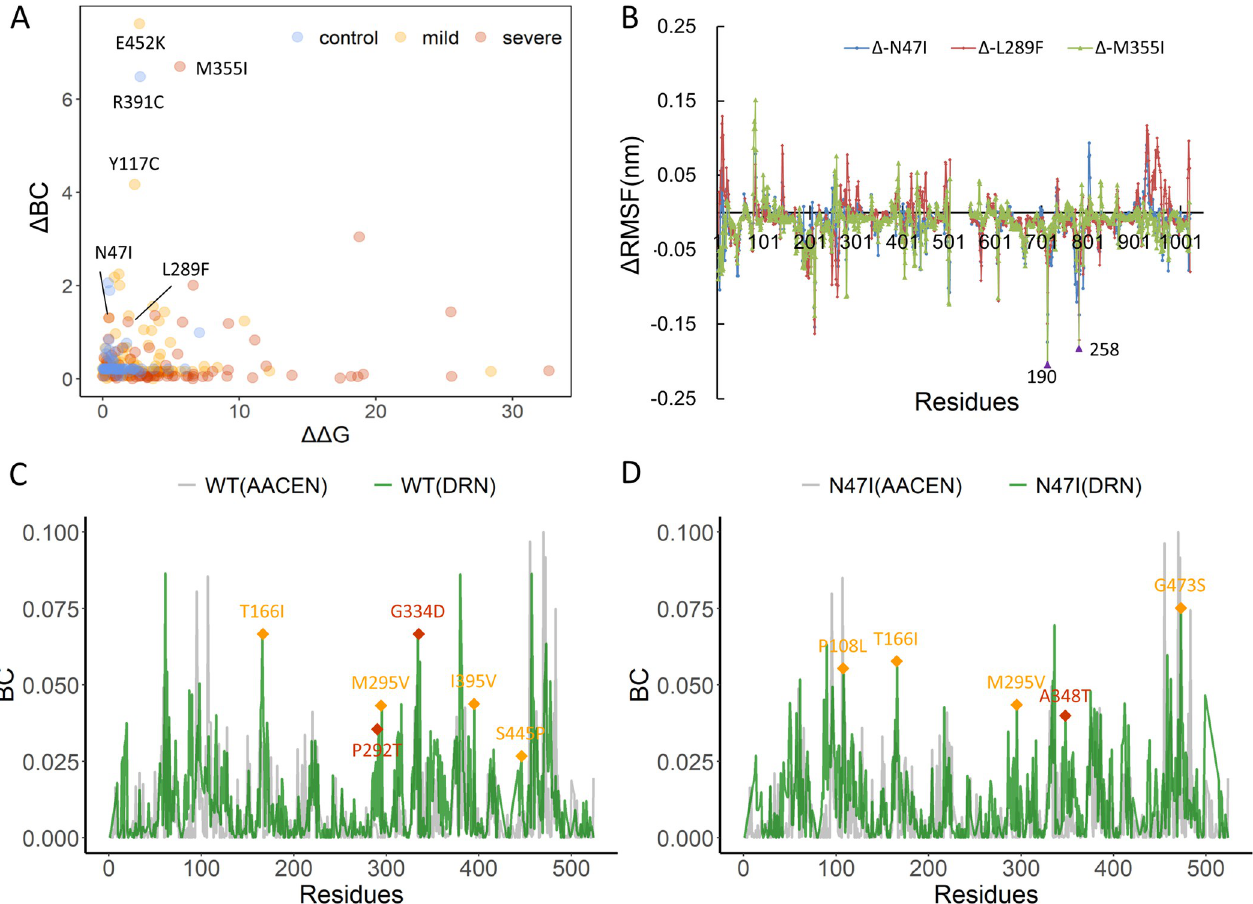
Fig 7. (A) The distribution of ΔΔ G and Δ BC for ALPL mutations. Scatterplot showing the distribution of Δ BC vs ΔΔ G of different mutation types. Severe, mild and control mutations are depicted in red, yellow, and blue, respectively. N47I, L289F, and M355I are three severe mutations with low ΔΔ G and high Δ BC. Among the three significant mutations predicted by the scatterplot, two (E452K and R391K) were not originally included in the severe mutation group but were validated as two severe mutations in the newly collected clinical samples. (B) Mean values of three replicas of the differential RMSF ( Δ RMSF) of N47I (blue), L289F (red), and M355I (green) with respect to WT. For each system, a replica of 500 ns was singled out to compare the BC values of the two different networks of TNSALP WT (C) and N47I (D) mutant. The green and grey lines show the BC values of residues of DRN and AACEN. Mild and severe mutations are highlighted as yellow and red diamonds,